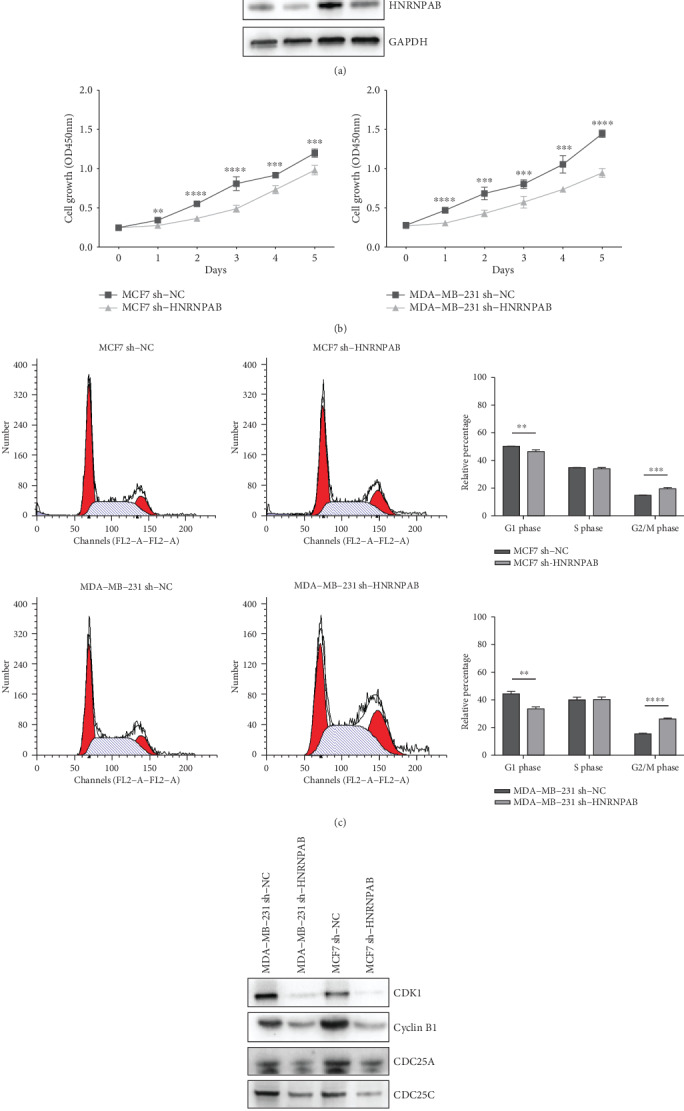
Experiments in vitro revealed the promotive effect of HNRNPAB on BC cells. (a) Western blot analysis of the efficiency of HNRNPAB knockdown. (b) HNRNPAB knockdown impeded the growth of BC cells. (c) HNRNPAB knockdown caused G2/M phase arrest in BC cells. (d) Western blot analysis of key regulatory molecules in G2/M phase transition in indicated BC cells. Data were shown as means ± SD, ∗∗p < 0.01; ∗∗∗p < 0.001; ∗∗∗∗p < 0.0001.